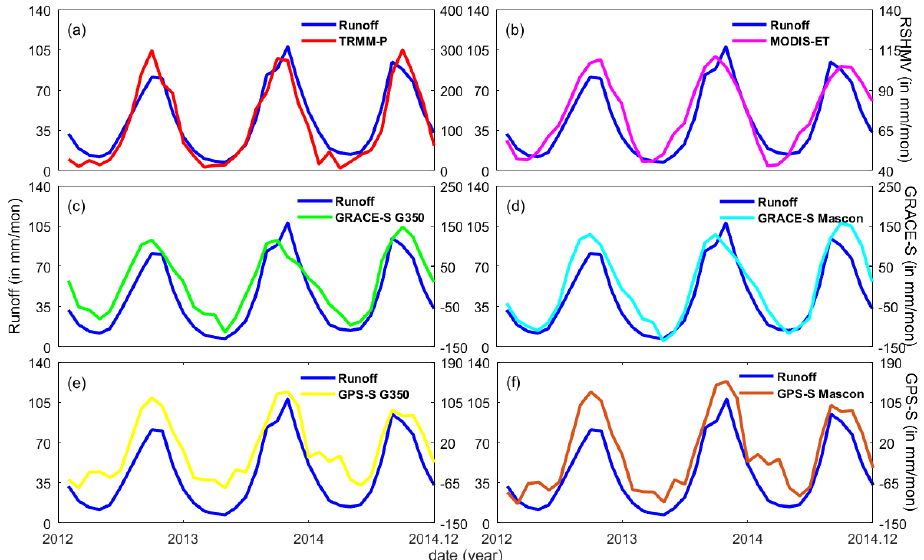
Figure 4. In-situ runoff time series compared to averaged ( a and b ) remotely-sensed precipitation (TRMM-P) and evapotranspiration (MODIS-ET), ( c and d ) GRACE water storage (GRACE-S) from CSR RL06 with a 350-km Gaussian Filtering (G350) and its mascon solution, and ( e and f ) GPS-inferred water storage (GPS-S) from CSR RL06 with a 350-km Gaussian Filtering (G350) and its mascon solution at Can Tho and My Thuan (CT-MT) station.